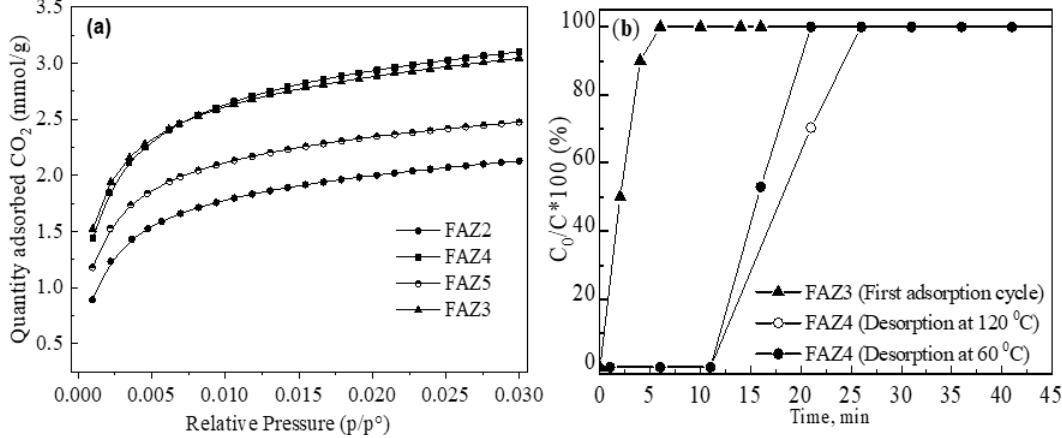
Figure 7. CO 2 adsorption studies: equilibrium isotherms ( a ) and dynamic breakthrough curves ( b ).